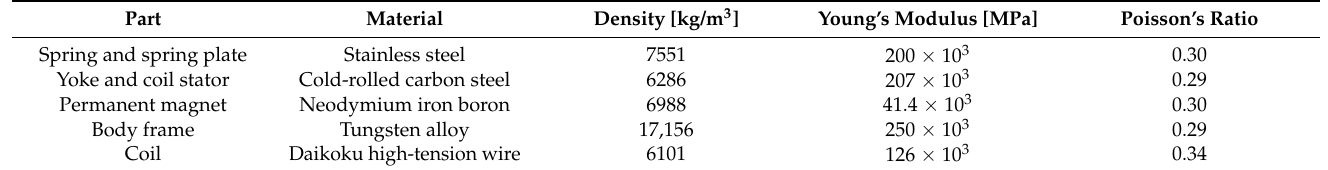
Table 1. Mechanical material